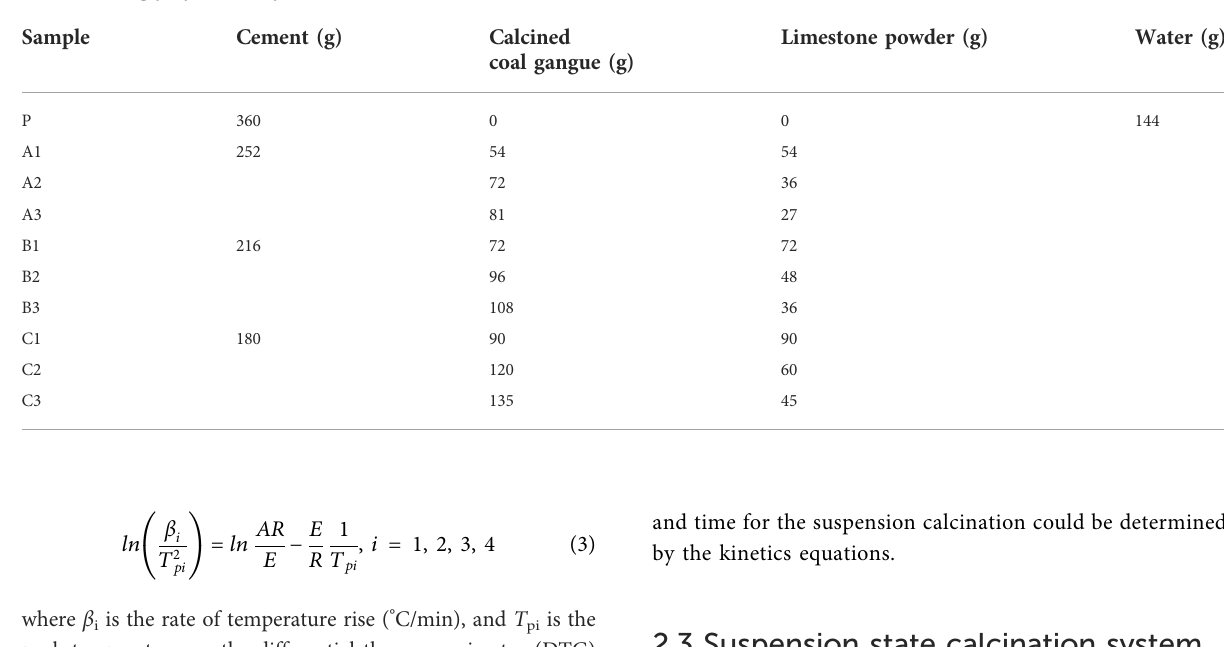
TABLE 3 Mixing proportion of pastes.